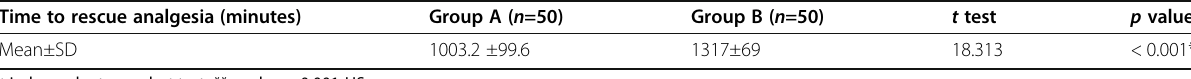
Table 7 Group A in comparison to group B according to time to rescue analgesia Time to rescue analgesia (minutes) Group A ( n =50) Group B ( n =50) t test p value Mean±SD 1003.2 ±99.6 1317±69